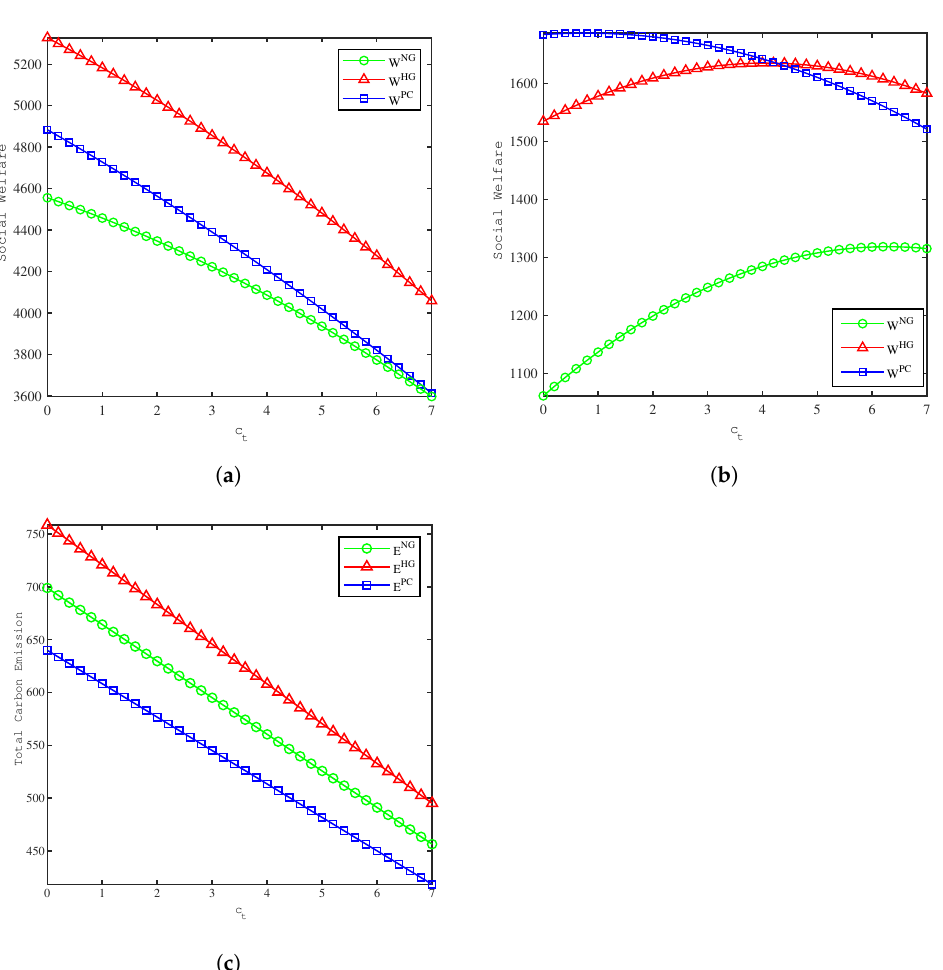
Figure 3. Comparison of the social welfare and total carbon emission between models. ( a ) Effects of c t on social welfare when λ = 10. ( b ) Effects of c t on social welfare when λ = 15. ( c ) Effects of c t on total carbon